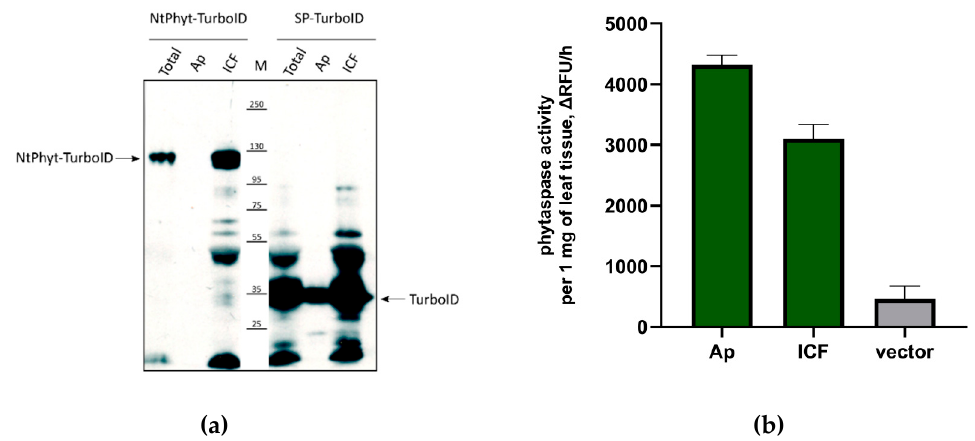
Figure 2. Evaluation of the stability of Nt Phyt-TurboID and SP-TurboID proteins in the apoplast and inside the plant cells. ( a ) For Nt Phyt-TurboID- and SP-TurboID-producing leaves, proteins in the apoplastic washes (Ap) and intracellular fractions (ICFs) were analysed by Western blotting with HisProbe detection. ‘Total’ represents leaf extracts without fractionation. Equal amounts of leaf tissues (5 mg) were taken for protein analyses, and equivalent 15 µ L aliquots of the subcellular fractions were loaded on the gel. M, molecular weights of protein markers. Arrows indicate positions of the recombinant proteins. ( b ) Measurement of phytaspase proteolytic activity in the extracellular (Ap) and intracellular (ICF) fractions obtained from Nt Phyt-TurboID-producing leaves. ‘Vector’ total protein sample from leaves infiltrated with agrobacteria carrying the empty vector. Ac-VEID-AFC (20 µ M) was used as the phytaspase substrate for quantitative assessment of phytaspase proteolytic activity. Relative rates of hydrolysis were determined as an increase of relative fluorescence units per hour (deltaRFU/h). Enzymatic activities were normalized by the weight of leaf tissues taken for analysis. Data represent the mean of three independent experiments ± standard deviation